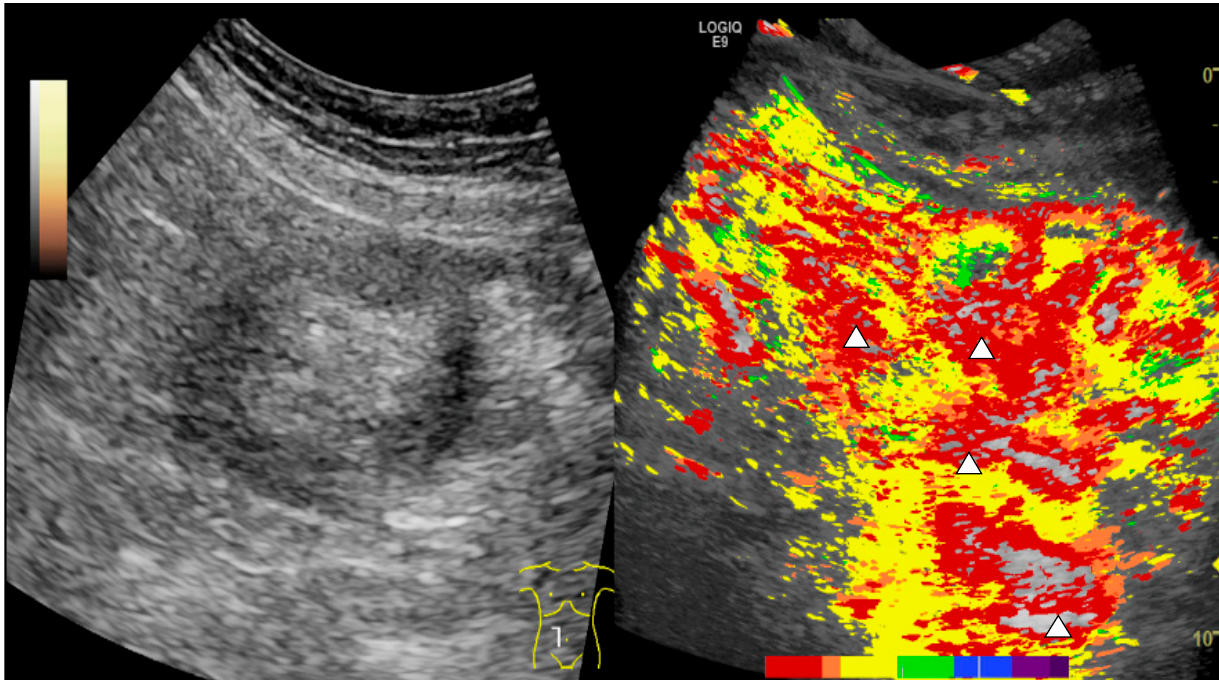
Figure 2. CEUS parametric imaging for the detection of acute GI GvHD. Parametric images of the same patient showing a region of the small intestine with early arterial hyperenhancement color coded in red and transmural penetration of microbubbles (white arrows).